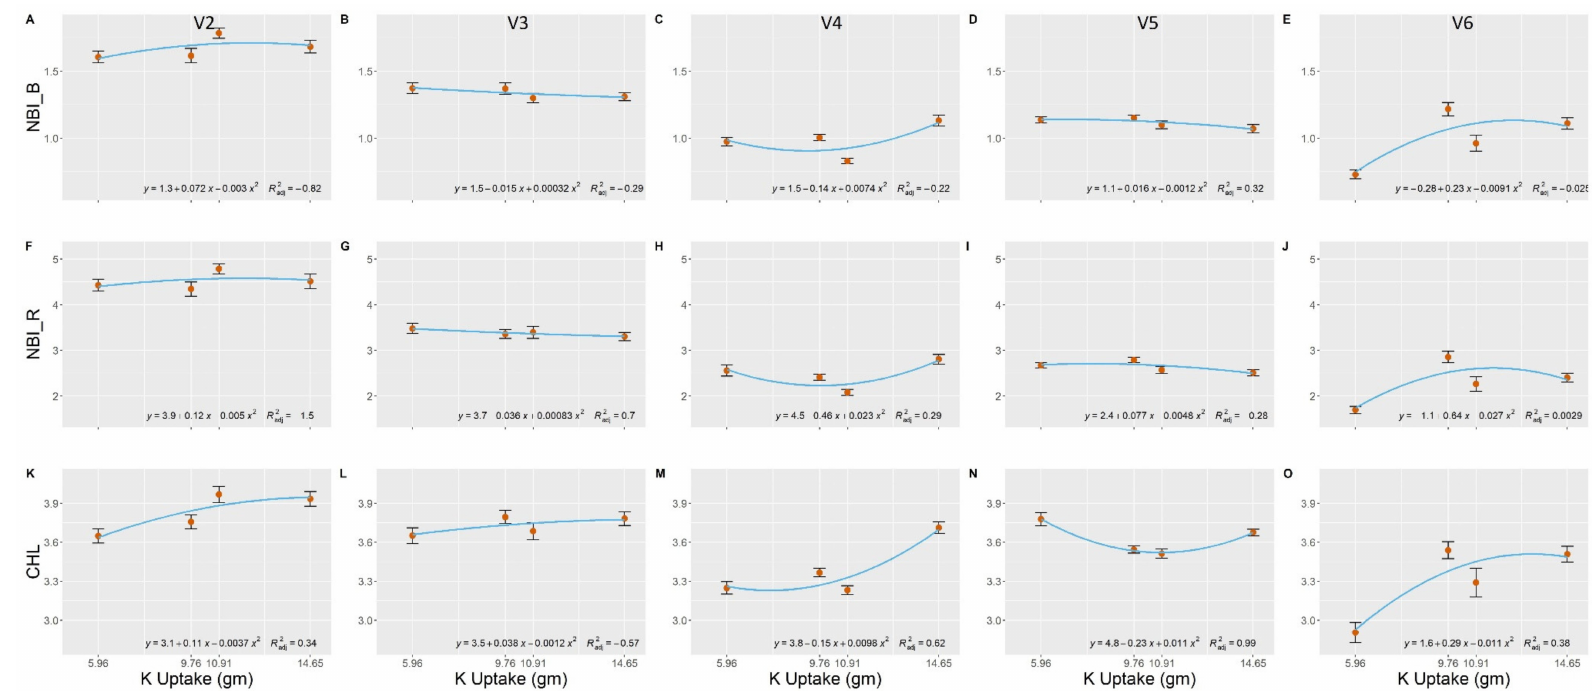
Figure 4. Fluorescence indices as a function of K uptake generated by di ff erent nutrient solutions with K variability in maize at four di ff erent crop growth stages under greenhouse conditions. V2 refers to the 10th day after emergence (DAE) and V3, V4, V5, and V6 refer to the crop growth stages at the 18th, 26th, 35th, and 38th DAE, respectively. Bars represent the confidence intervals ( α = 0.05), and fitted curves are quadratic polynomials with their respective coe ffi cients of determination (R 2